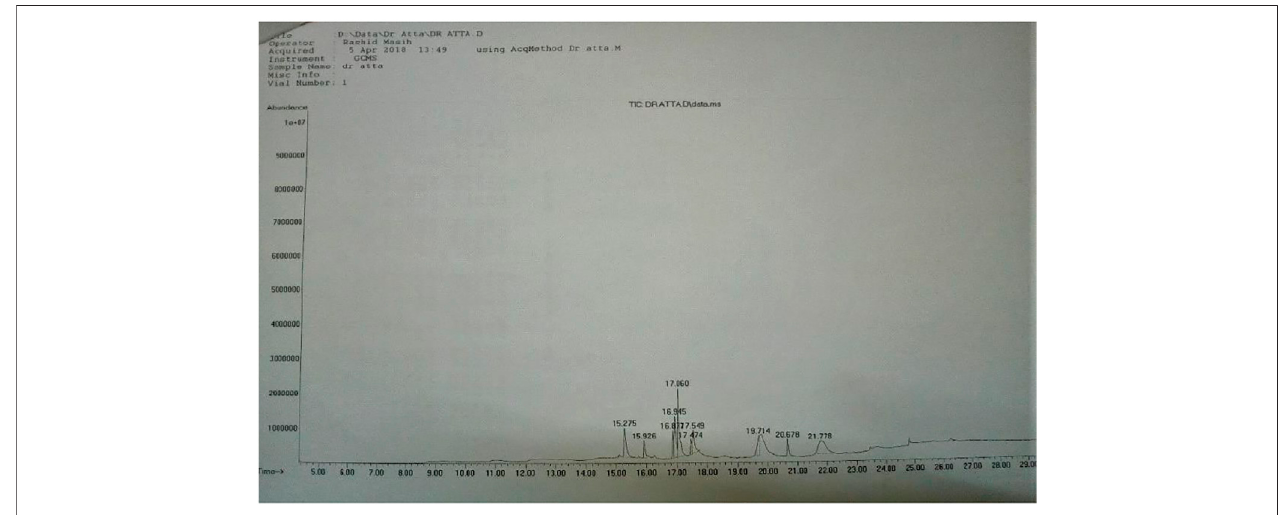
FIGURE 2 | GCMS chromatogram of GREE.